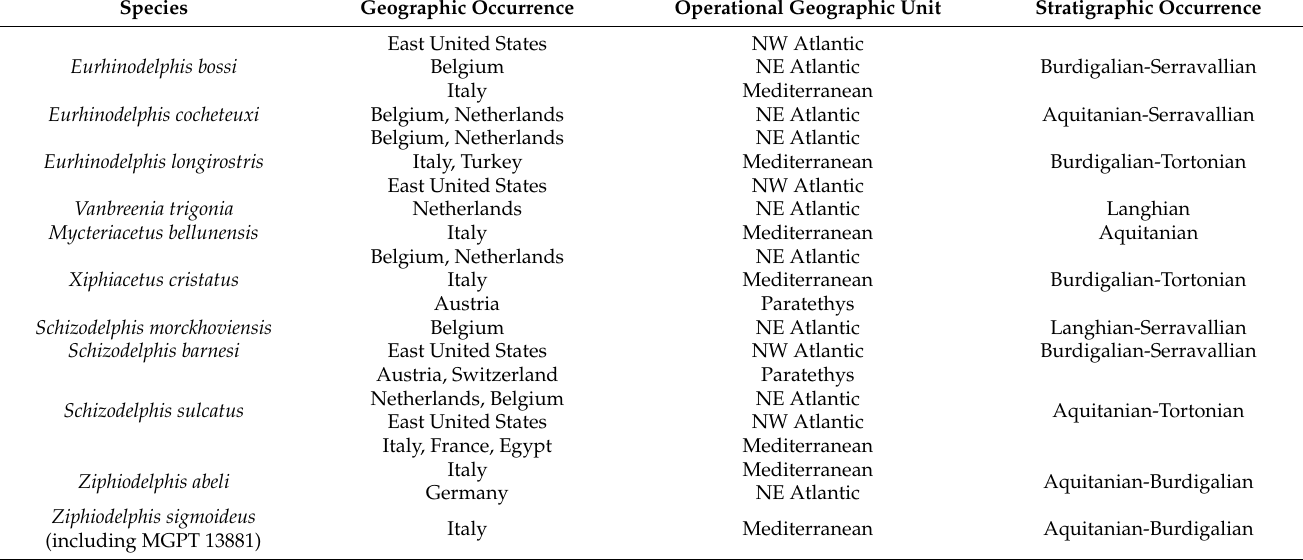
Table 2. Geographic and stratigraphic occurrences of the eurhinodelphinid taxa used in the phylogenetic analysis. Data downloaded from Paleobiology Database (last accessed on 11 November